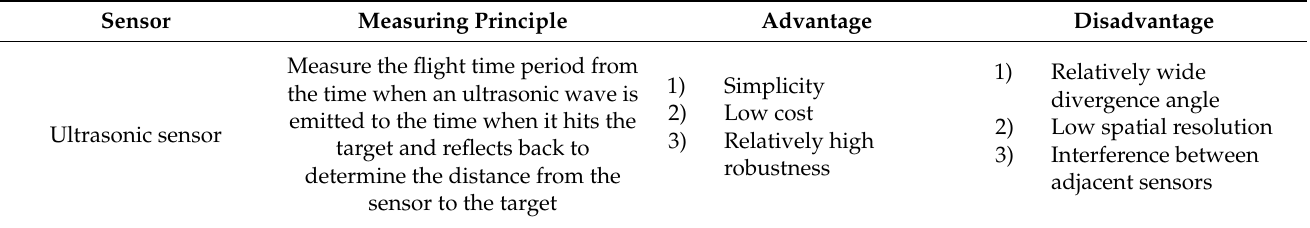
Table 1. Physical principles, advantages, and disadvantages of the ultrasonic sensor and the LiDAR sensor